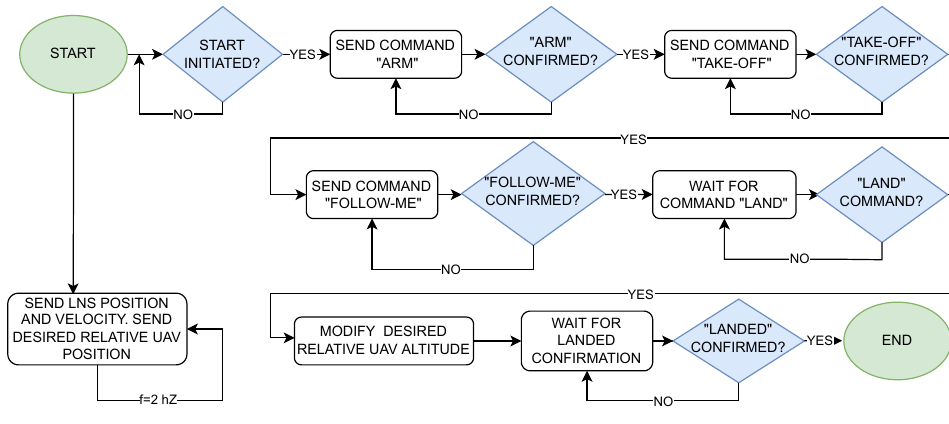
Figure 11. Algorithm flowchart.